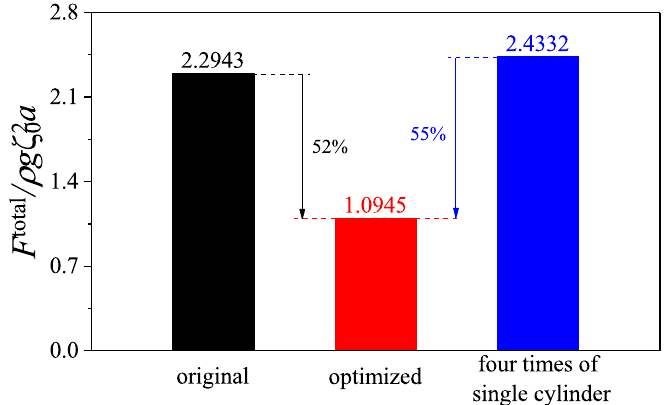
Figure 15. The total wave drift forces on the original structure, optimized structure and four times of single cylinder at k 0 a = 1.68.